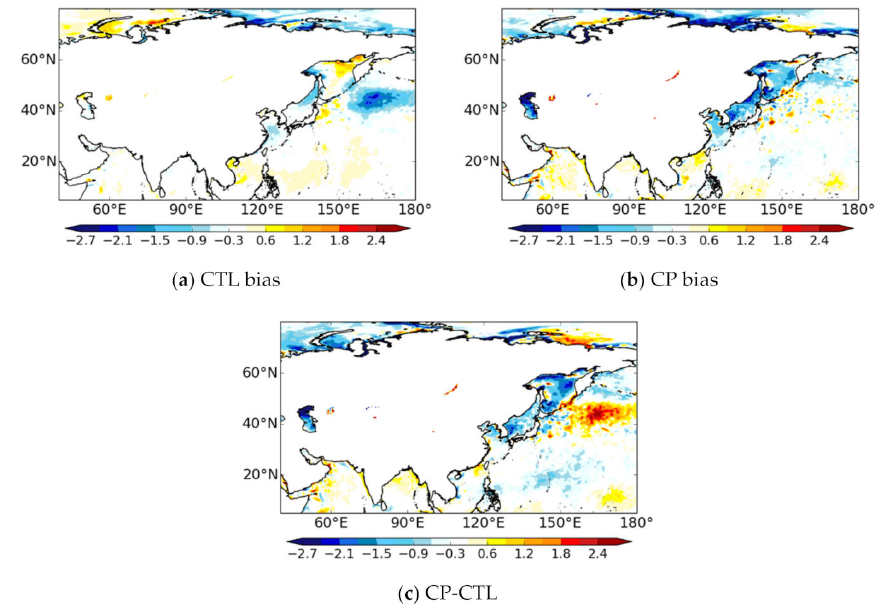
Figure 13. Bias of SST (K) in the ( a ) CTL experiment and ( b ) CP experiment. ( c ) Di ff erences of SST between the CP and the CTL experiment (CP minus CTL). Biases are calculated from the operational sea surface temperature and sea ice analysis (OSTIA) data [40]. Both experiments are 7-day forecasts and averaged during 11–25 August